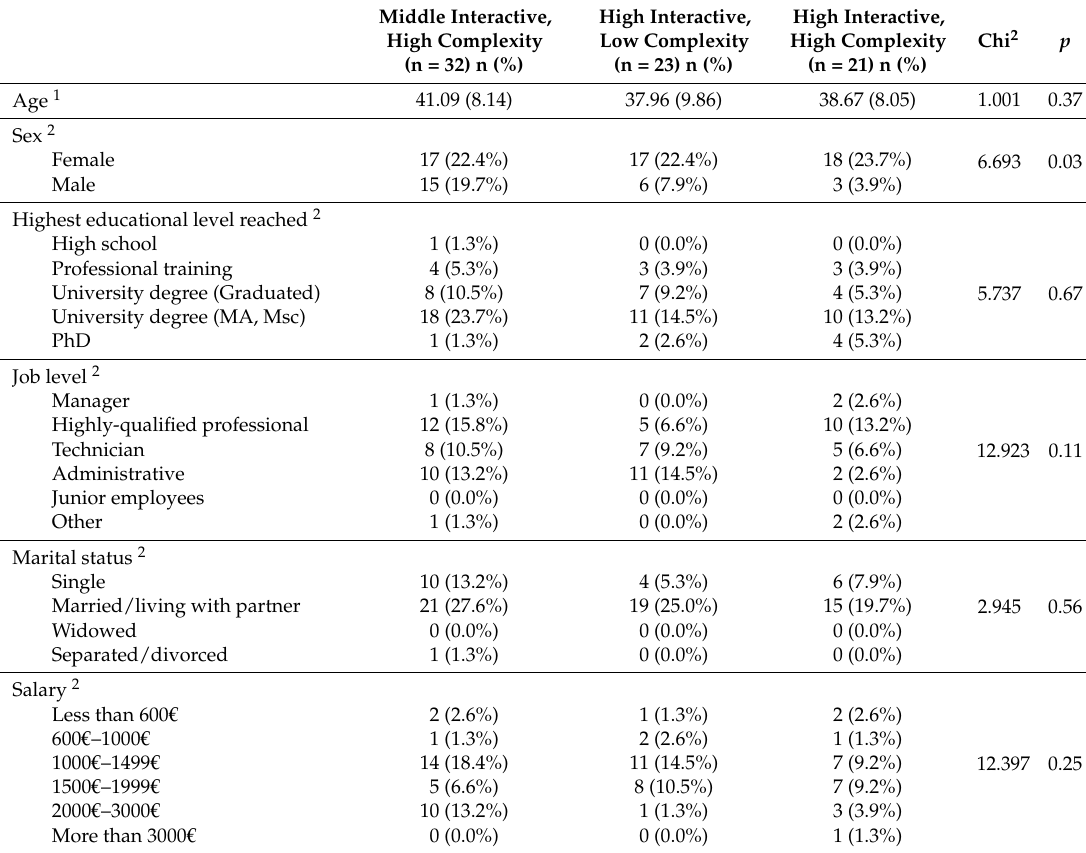
Table 1. Work patterns: sample characteristics.